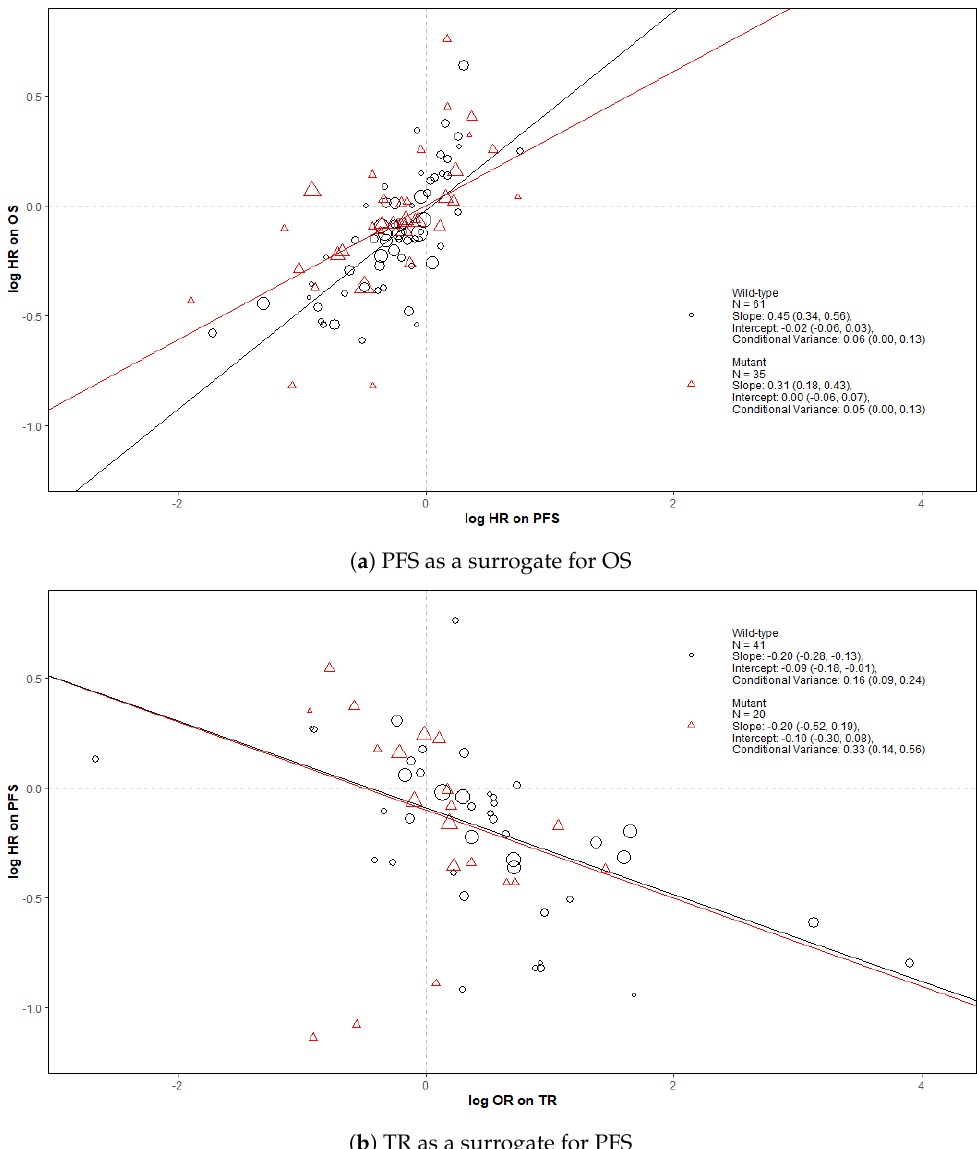
Figure 2. Bubble plots of the surrogate relationships in trial-subgroups of patients with KRAS WT and MT metastatic colorectal cancer (mCRC). The Slope, Intercept and Conditional variance are mean estimates with 95% Credible Intervals obtained from Daniels and Hughes model. N represents the number of trial-subgroups. HR = Hazard Ratio, OR = Odds